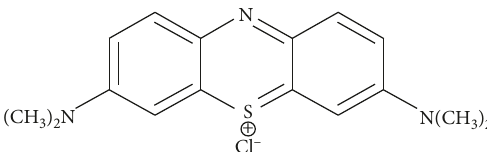
Figure 1: Molecular structure of methylene blue dye